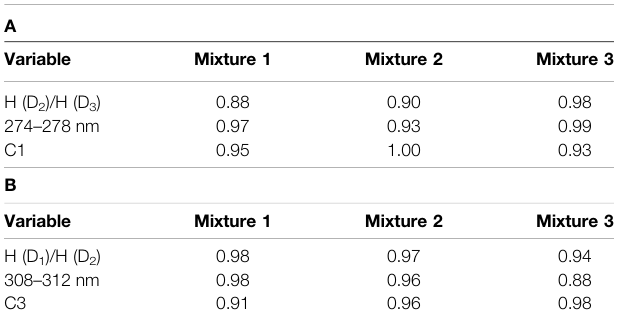
Frontiers in Environmental Chemistry |